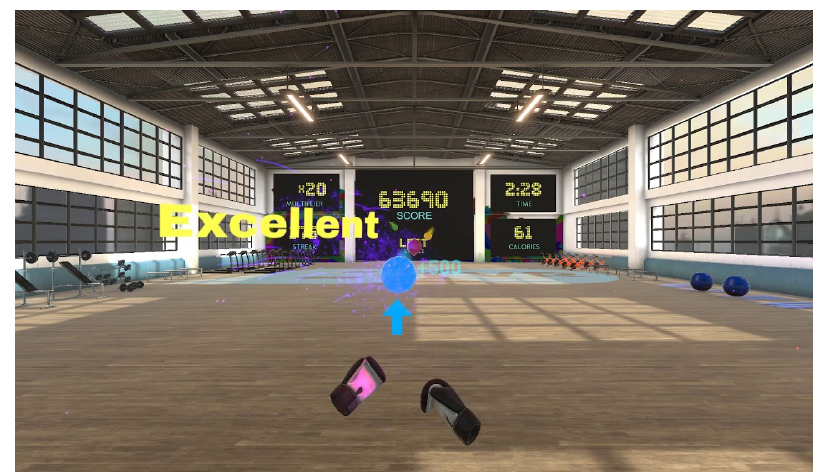
Figure 4. Screenshot of the exergame proposed (BOX VR) for training sessions.